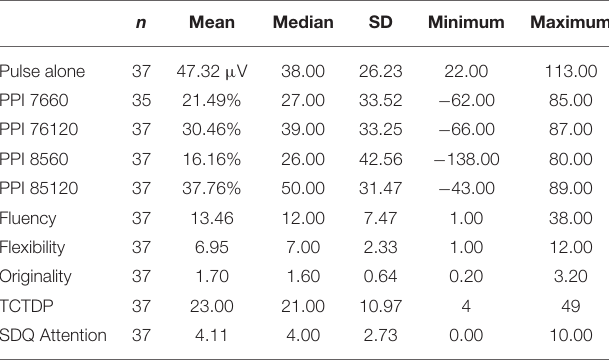
TABLE 2 | Descriptive statistics of the PPI parameters, creativity variables, and the SDQ attention scale.